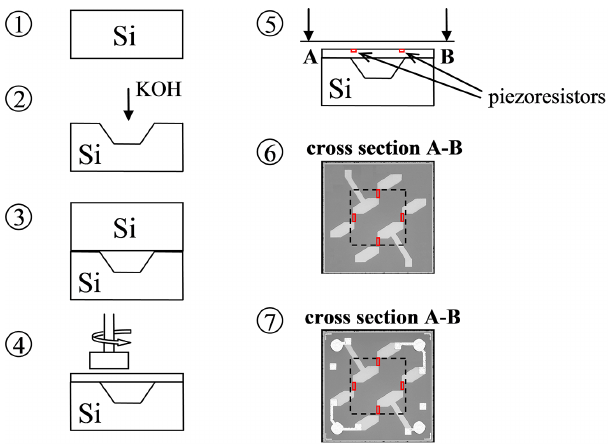
Figure 2. Pressure sensor chip fabricated in SOI technology. (1) A pure silicon wafer. (2) Cavities are etched by KOH etching. (3) A second silicon wafer is bonded onto the cavity wafer. (4) The bending plates are formed by grinding the second wafer. (5) Four piezoresistors are formed by doping on the bending plate. (6) The resistors are connected as a Wheatstone bridge by highly doped ar- eas and (7) aluminum lines.